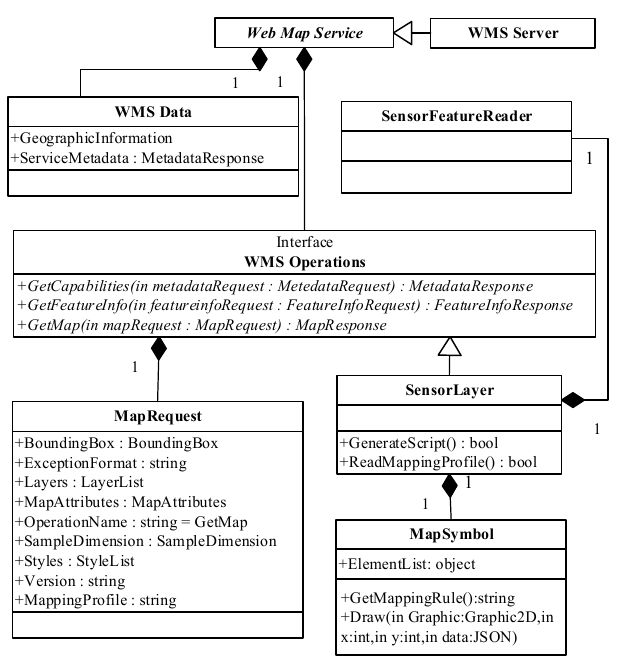
Figure 8. Outline of the SensorLayer class and Web Map Service.